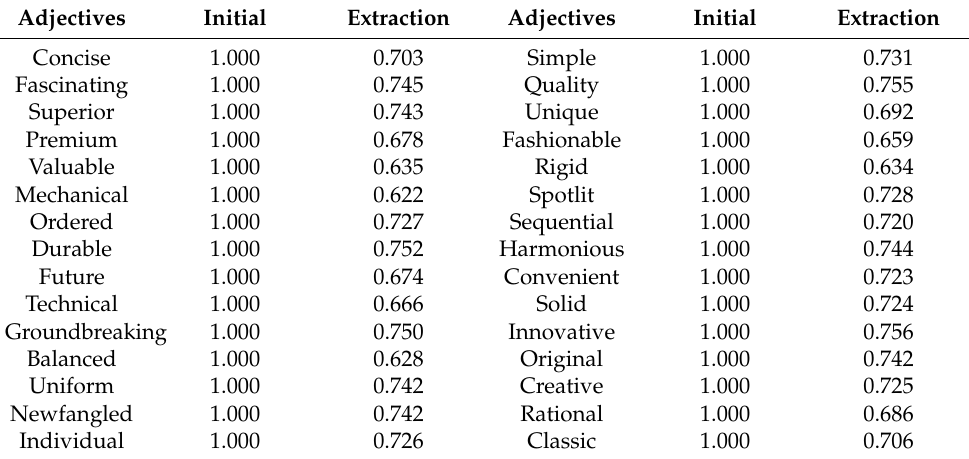
Table 6. Thirty adjective factors with absolute load capacity values greater than